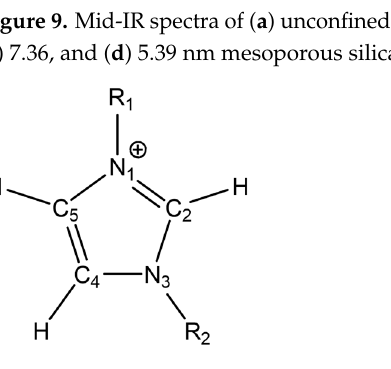
Scheme 1. Numbering system for the imidazolium cation.